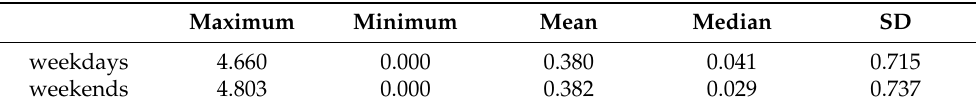
Table 2. The statistical characteristics of urban vitality index in urban waterfronts on weekdays and weekends.